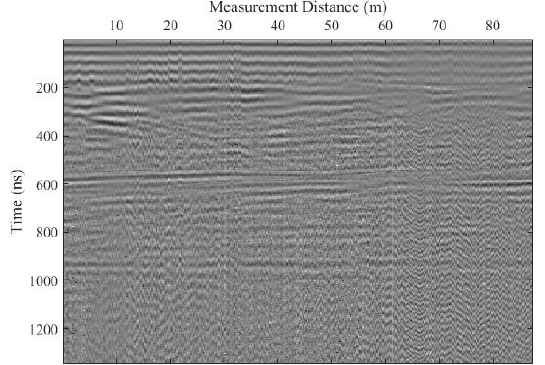
Figure 11. The field GPR dataset.